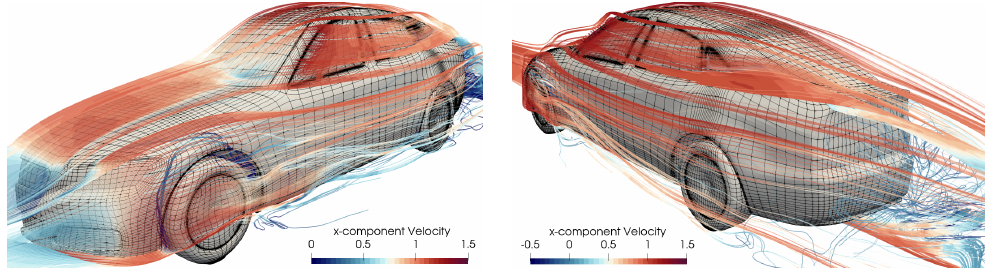
Figure 22. DrivAer model—Streamlines coloured with the x -component of the velocity for the time-averaged solution from the front ( left ) and the rear ( right ) point of